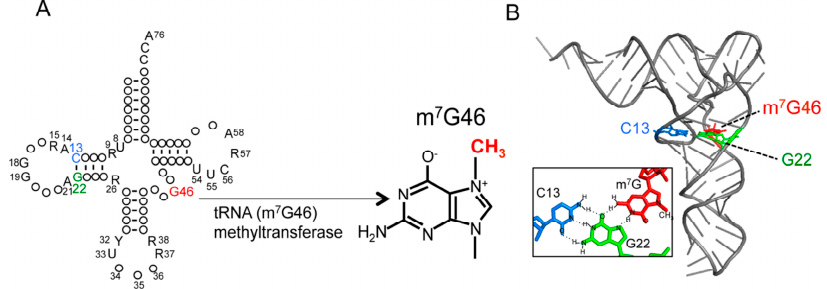
Figure 1. tRNA m 7 G46 methyltransferase methylates the N7-atom of guanine at position 46 in tRNA and forms m 7 G46. ( A ) The secondary structure of tRNA is presented in cloverleaf form. Conserved nucleotides are depicted as follows: adenosine, A; guanosine, G; cytidine, C; uridine, U; purine, R; pyrimidine, Y. tRNA (m 7 G46) methyltransferase transfers a methyl-group to the N7-atom of guanine at position 46 in tRNA and forms 7-methylguanine. ( B ) The L-shaped structure of tRNA is presented. The